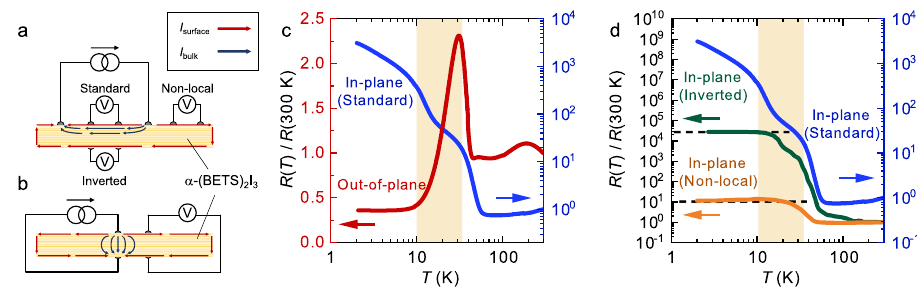
Fig. 2 | Measurement of the temperature dependence of resistance in α - (BETS) 2 I 3 . a Standard and inverted con fi guration for the four-terminal in-plane resistance measurement. Excitation currents were applied from the two terminals onthetopsurfaceofthecrystal,andthevoltagedropbetweenthetwoterminalson the top surface (standard con fi guration) and a back surface (inverted con fi gura- tion) was measured. The red and blue arrows represent the current fl ows via the surface and the bulk, respectively. b Setup for the out-of-plane resistance mea- surement. c Temperature dependence of the standard in-plane resistance (blue curve) for Sample #1 and the out-of-plane resistance (red curve) for Sample #2.